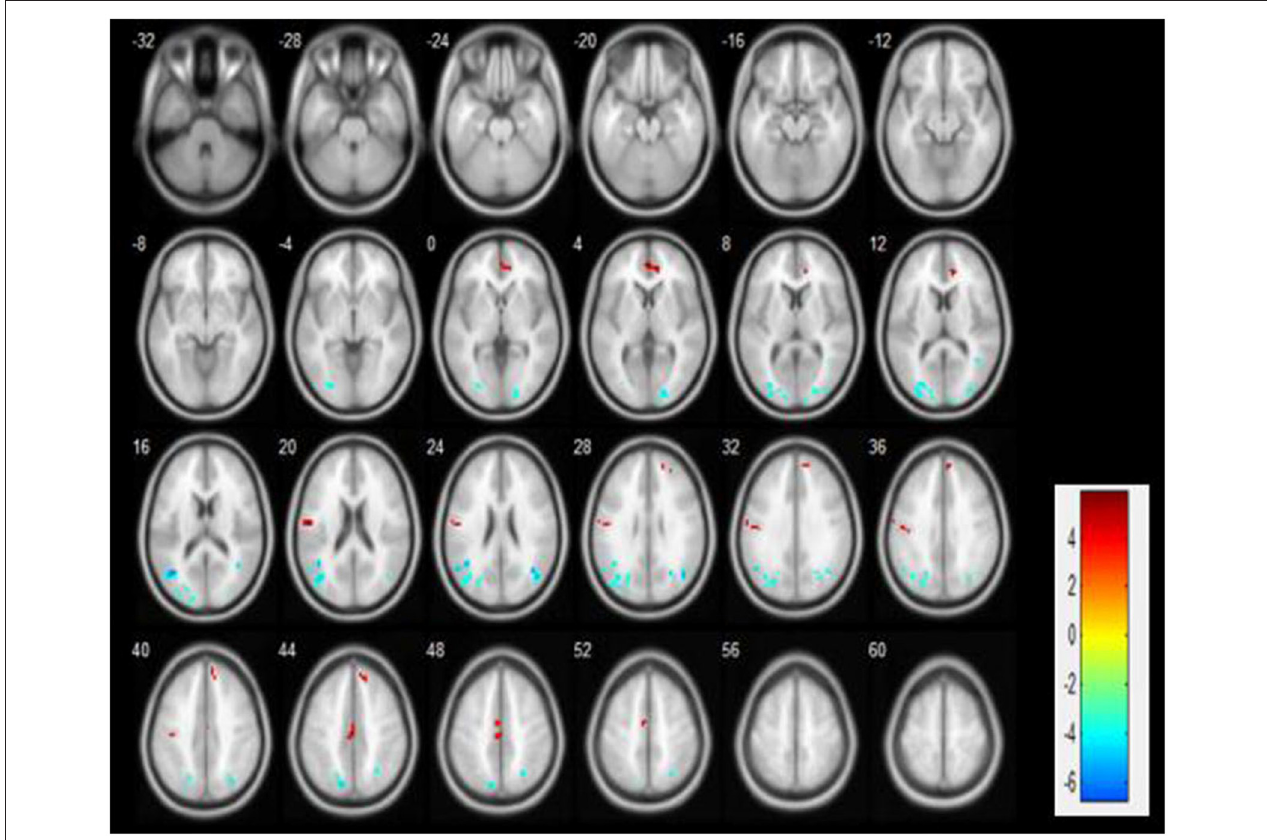
FIGURE 3 | Compared with the education group, the ALFF brain area changes in the PLWNT group. Red shows enhanced area, green shows reduced area, based on FWE correction, with voxel level p < 0.001 and cluster level p <